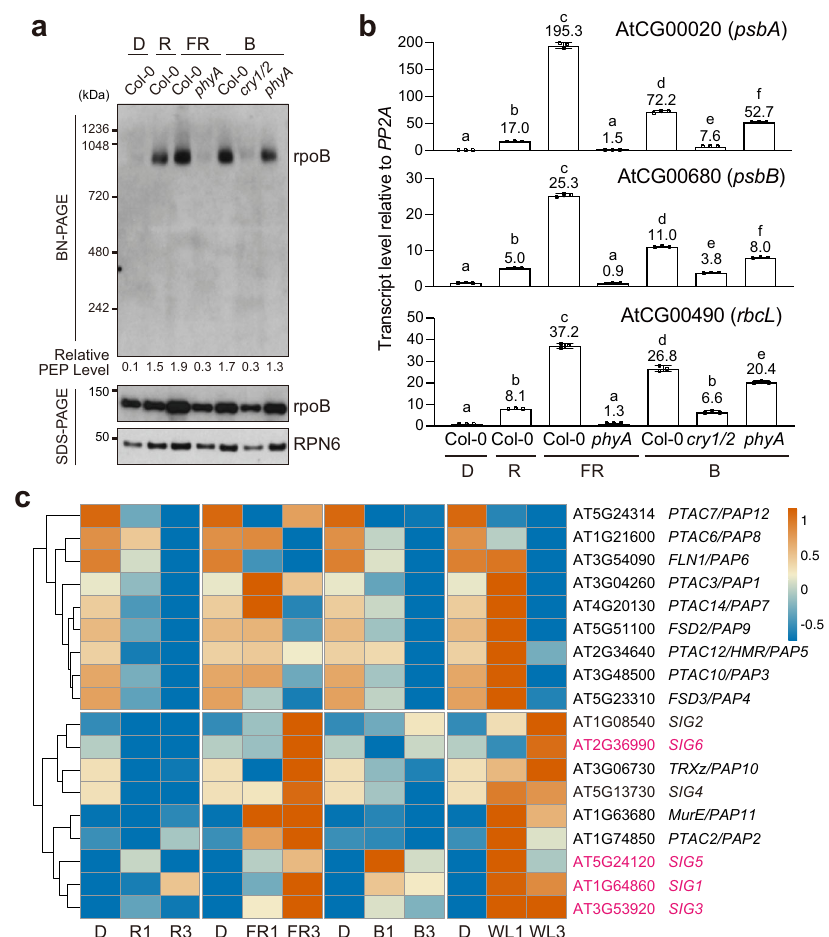
Fig.8|PIF-repressedsigmafactorsarerapidlyinducedbylight.a Immunoblots showingthelevelsofthePEPcomplexandthePEPcomponentrpoBin4-d-oldCol- 0, phyA-211 ( phyA ), and cry1/cry2 ( cry1/2 ) seedlings grown in the dark (D) or in 10 μ molm − 2 s − 1 monochromaticred (R), far-red (FR),orblue (B) light.Totalprotein was isolated under either native or denaturing conditions and resolved via BN- PAGEorSDS-PAGEtoassessthefractionofrpoBinthePEPcomplexortheamount of total rpoB by immunoblots, respectively. RPN6 was used as a loading control. ThenumbersbelowtheimmunoblotsrepresenttherelativePEPlevels,whichwere estimatedusingtherelativelevelofrpoBinthePEPcomplex(BN-PAGE)dividedby therelativelevelofdenaturedrpoB(SDS-PAGE)ineachsample. b qRT-PCRanalysis of the steady-state transcript levels of psbA , psbB , and rbcL in 4-d-old Col-0, phyA-